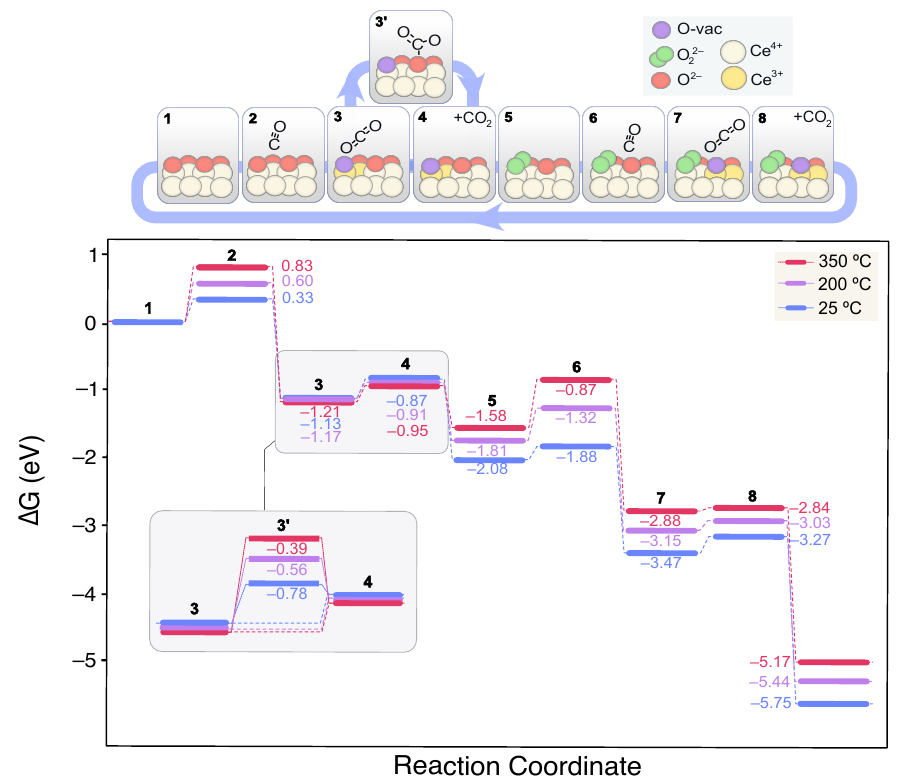
Figure 6. Calculated Gibbs energy diagram for the CO oxidation mechanism on a stoichiometric CeO 2 (111) clean surface at different experimental temperatures. The structures of the different reaction intermediates are depicted at the top of the